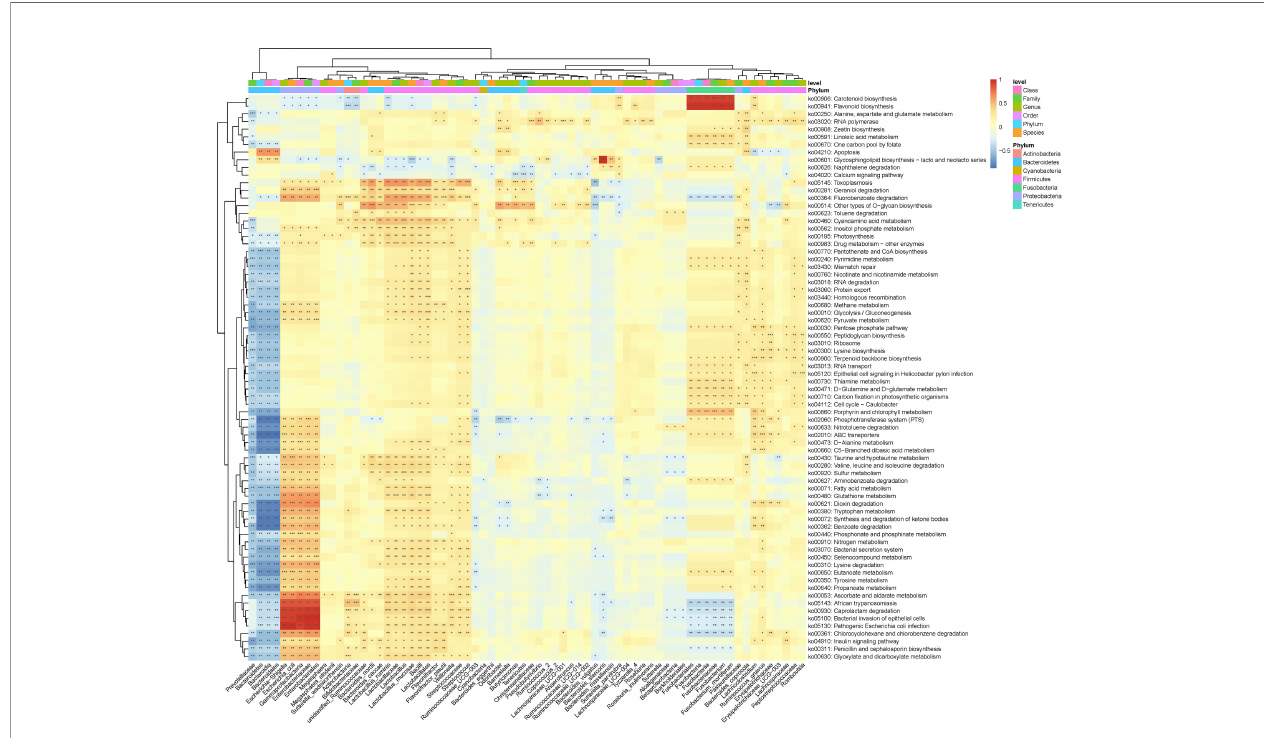
FIGURE 7 | Association between differential KEGG pathways and microbiota composition at the previously depicted differential bacteria. Notes: * p < 0.05, ** p < 0.01, *** p <